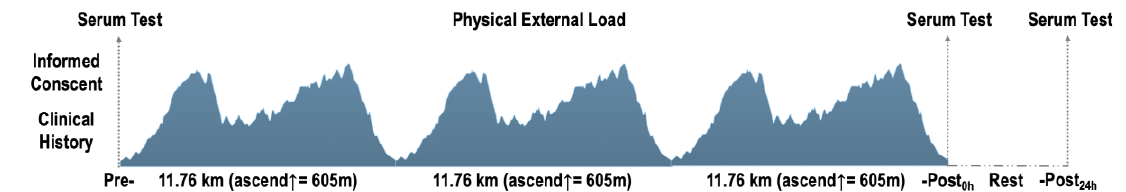
Figure 1. Schematic design of study variables with time measurement and trail altimetry.